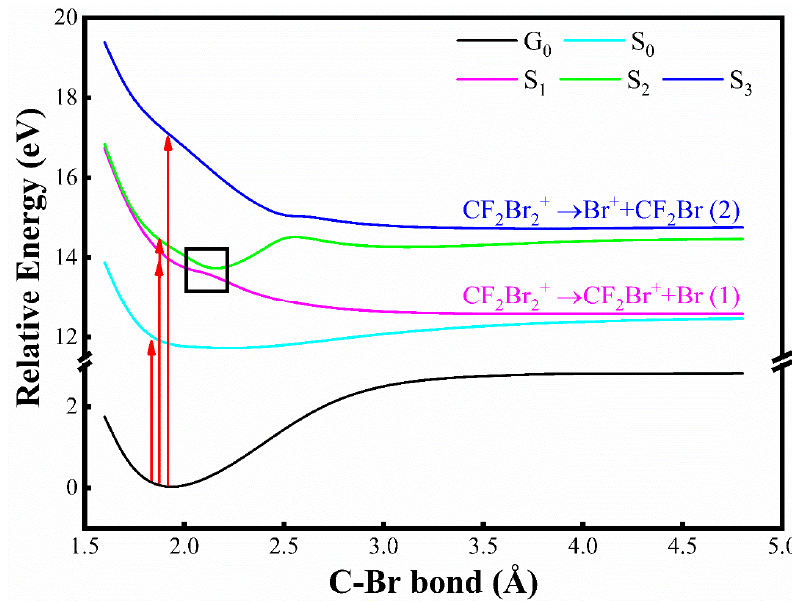
Figure 7. Potential energy surfaces (PESs) of ground state of neutral molecule CF 2 Br 2 , parent ion CF 2 Br 2+ and the excited states of ion CF 2 Br 2+ , which were calculated at the equation of motion coupled cluster singles-and-doubles (EOMCCSD)/cc-pVTZ level.